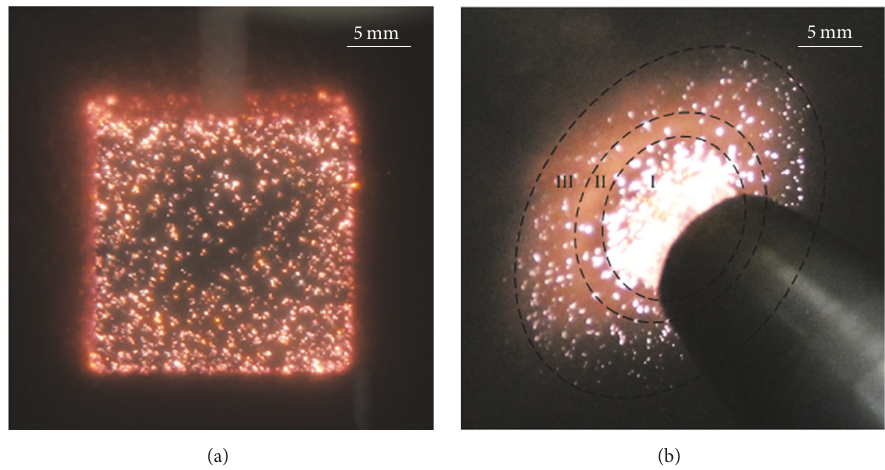
Figure 4: Comparison of spark discharges in (a) MAO and (b) SMAO after 2min of